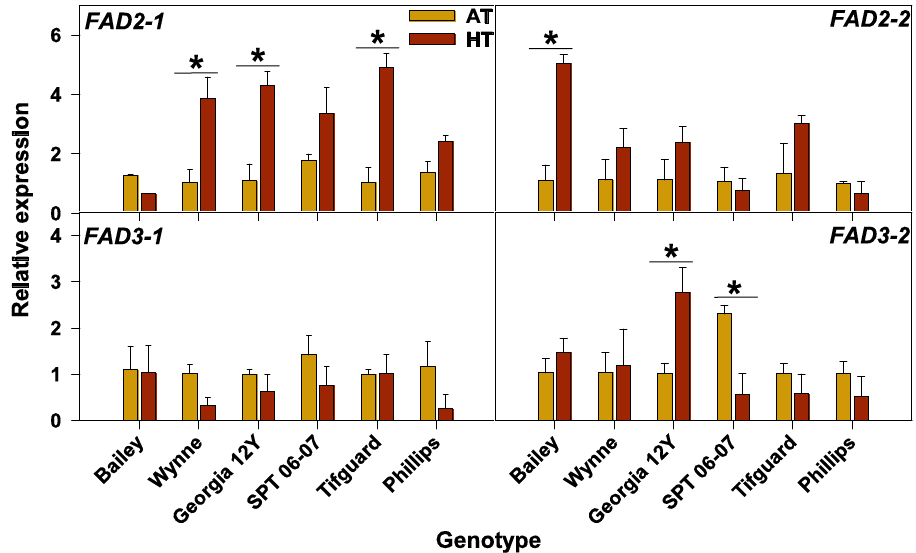
Figure 9. Changes in expression levels of the Fatty Acid Desaturase (FAD) genes: FAD2-1 , FAD2-2 , FAD3-1 , and FAD3-2 under heat stress in the anther samples of six peanut cultivars grown under field conditions in 2019. RT-PCR was performed using gene-specific primers, and in all cases, gene expression results are normalized to the expression of the housekeeping gene Actin-7 (see Supplementary Table S4). For qRT-PCR analysis, three biological and two technical replicates were used. Asterisk (*) marks indicate significant differences (> 1.5-fold) in the expression level of the FAD genes observed under two treatments. The error bars signify the standard error. AT, ambient temperature (28/22 °C; average day/night temperatures during the 18-days treatment period); HT, high temperature (38/26